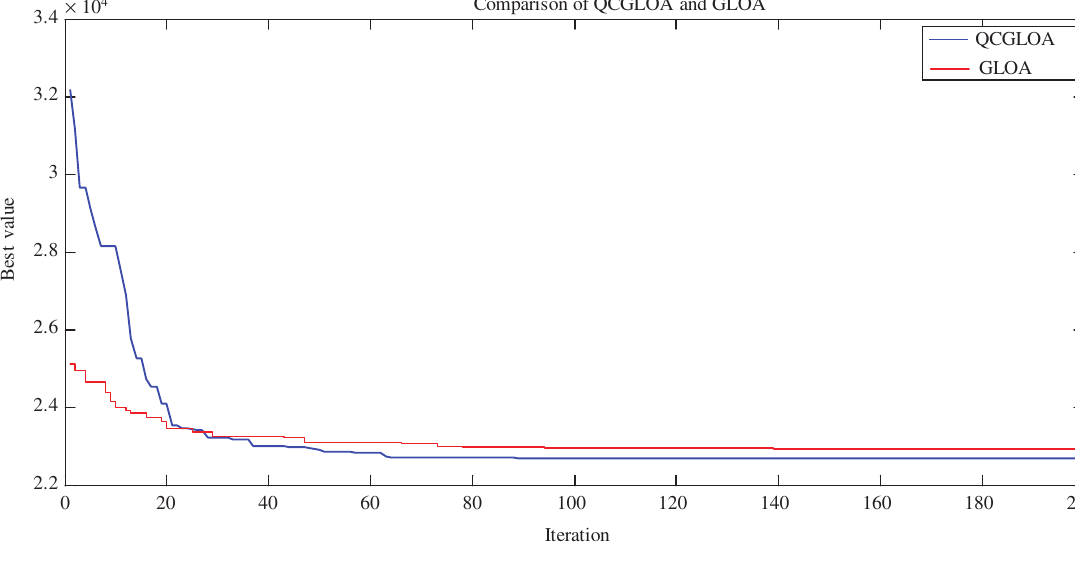
Figure 3: Simulation Result of QCGLOA Compared with GLOA.